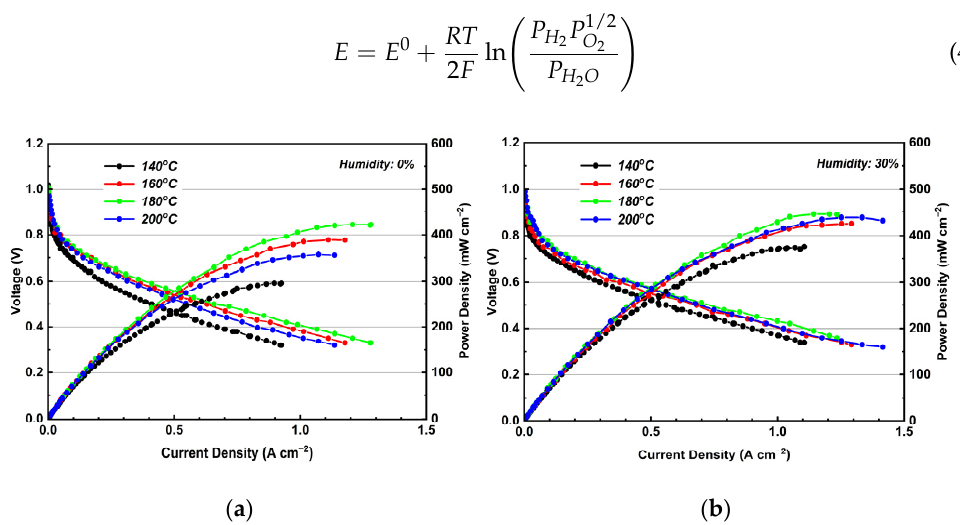
Figure 13. ( a ) I-V-P curves of treated PBI/K MEA at 140–200 °C under ( a ) dry and ( b ) 30% RH gas conditions. (Equal H 2 and O 2 flow rates at 0.4 L min − 1 ). Table 1. Comparison of the performance of some PBI-based composite membrane.